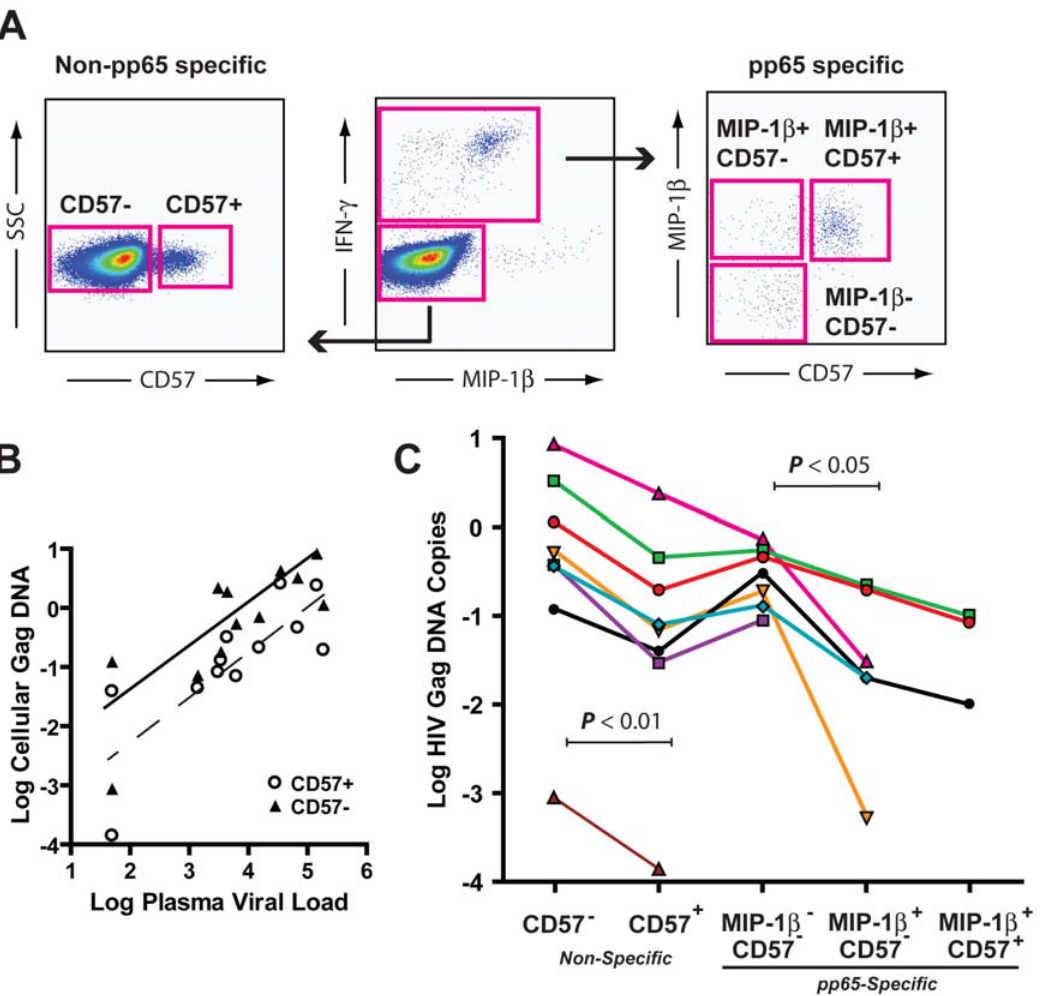
Figure 6. MIP-1 b producing pp65-specific CD4 + T cells have a lower frequency of HIV infection than do non-MIP-1 b producing pp65 specific CD4 + T cells. A) PBMC were incubated in the presence of BFA and pp65 15mers overlapping by 11 for six hours. pp65-specific CD4 + T cells were separated from memory CD4 + T cells based on production of IFN c . Cells which were non-pp65 specific were sorted into CD57 + and CD57 2 populations. Cells which were pp65-specific were sorted in MIP-1 b + CD57 + , MIP-1 b + CD57 2 , or MIP-1 b 2 CD57 2 populations. Quantitative real time PCR was done on each of these populations to determine the frequency of cell associated gag DNA. B) In all 12 individuals studied, CD57 + non-pp65 specific cells (open circles) had lower frequencies of cell associated gag DNA than did CD57 2 non-pp65-specific cells (solid triangles) ( P , 0.01). For both CD57 + and CD57 2 CD4 + T cells log plasma viral load was linearly related to log cell associated gag DNA ( P , 0.01). R 2 values were 0.62 for CD57 + cells and 0.67 for CD57 2 cells. C) A plot of the log of cell-associated gag DNA in pp65-specific and non-specific CD4 + T cells from 8 HIV-infected individuals. Non-pp65-specific CD4 + T cells that were CD57 + had lower amount of cell associated Gag DNA than did non-pp65 CD57 2 CD4 + T cells ( P , 0.01). CD57 2 CD4 + T cells which were pp65-specific and produced MIP-1 b had lower amounts of cell associated Gag DNA than did similar pp65- specific CD4 + T cells that did not produce MIP-1 b ( P , 0.05). Where values are not shown, the amount of cell associated gag DNA was below the detection limit of the